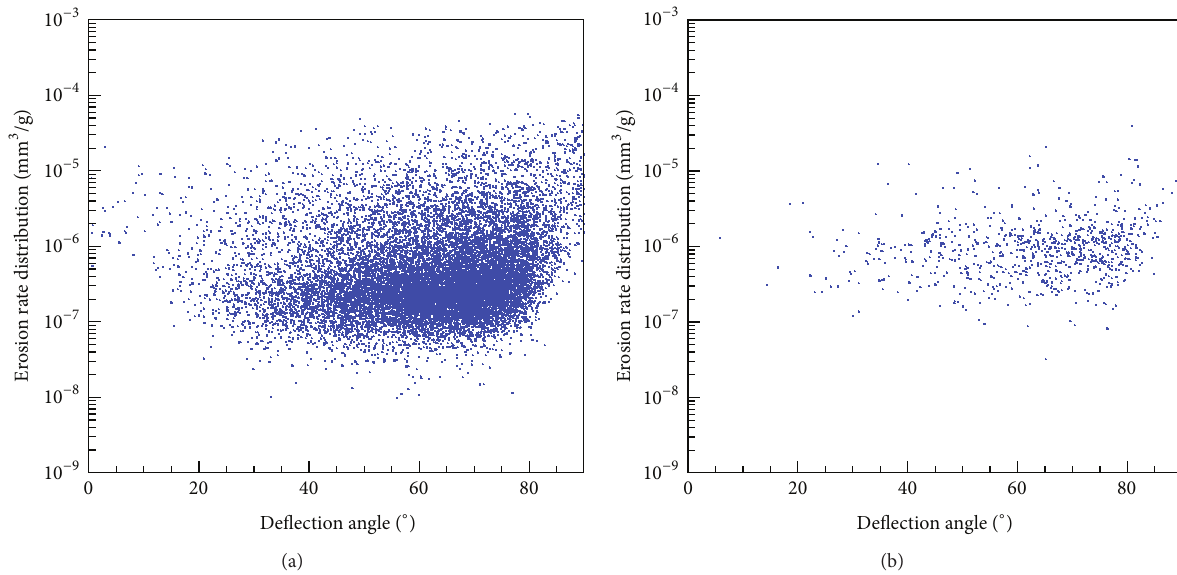
Figure 6: Erosion rate 𝐸 V distribution per impact particle against the deflection angle of curved duct at the inlet velocity 5.3 m/s: (a) particle diameter 16 𝜇 m and (b) particle diameter 7 𝜇